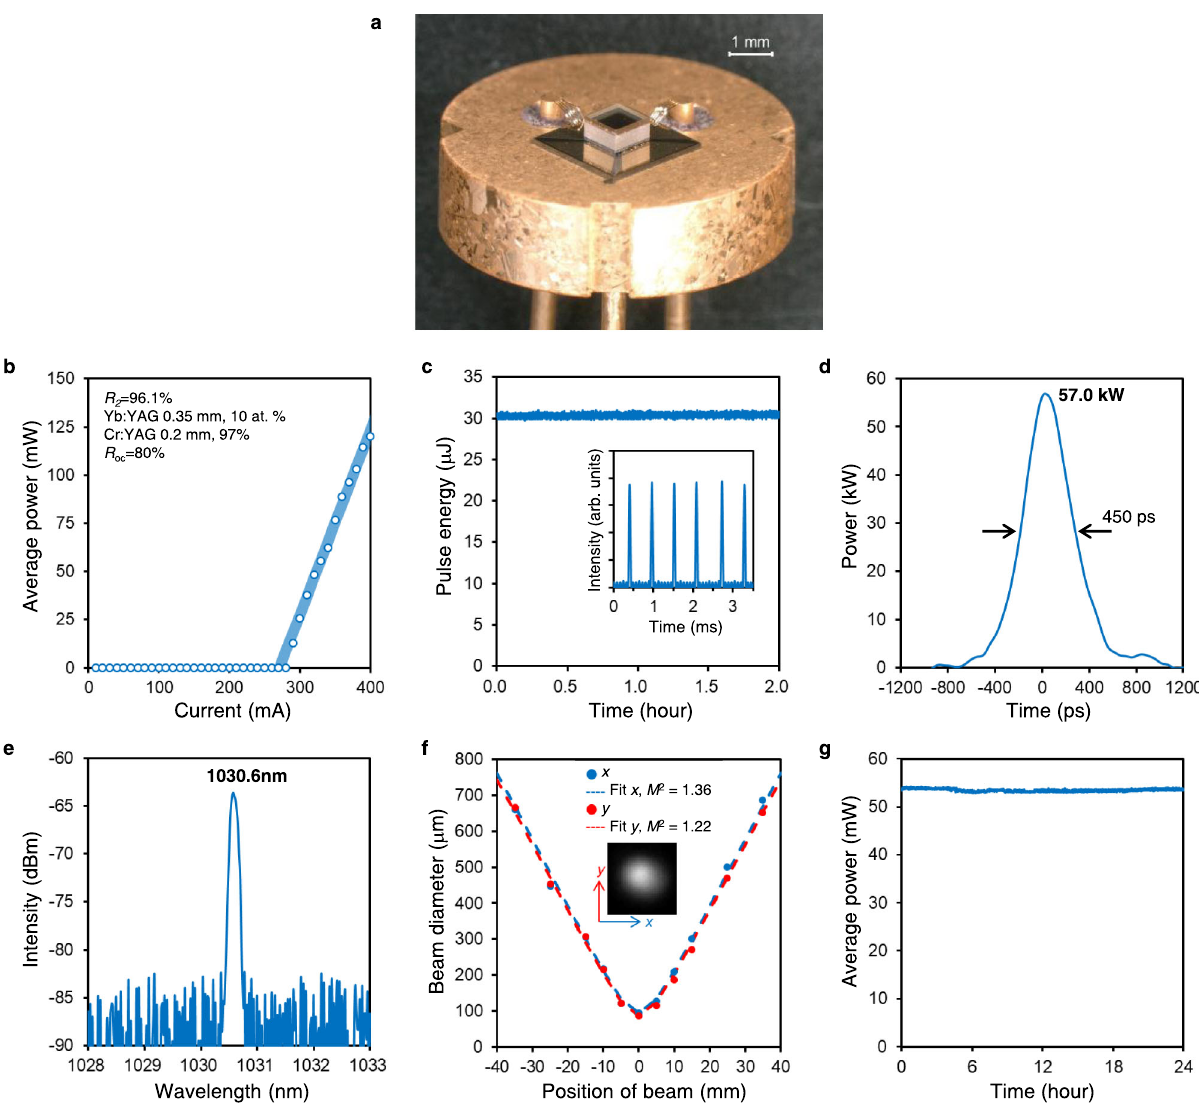
Fig. 5 | Demonstration of the chip-scale semiconductor/solid-state vertically integrated laser. a Photograph of the laser chip. b I – L characteristics. c Pulse energy stability (2h) of the chip-scale integrated laser (inset: temporal waveform). d Single-pulse waveform. The vertical axis was calculated from the obtained pulse